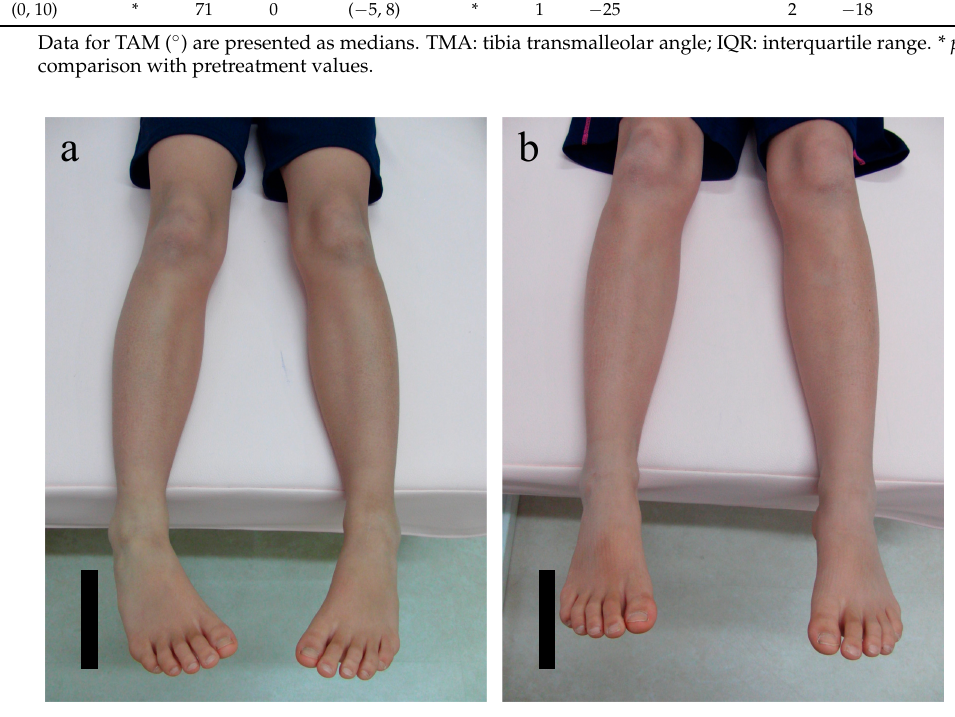
Figure 2. A 9-year-old boy provided with tibia counter rotator (TCR) treatment. ( a ) Pretreatment (TMA, right: − 30.0°; left: − 30.0°), ( b ) 12 months after pretreatment (TMA, right: 10°; left: 10°). TCR: tibia counter rotator, TMA: transmalleolar angle.